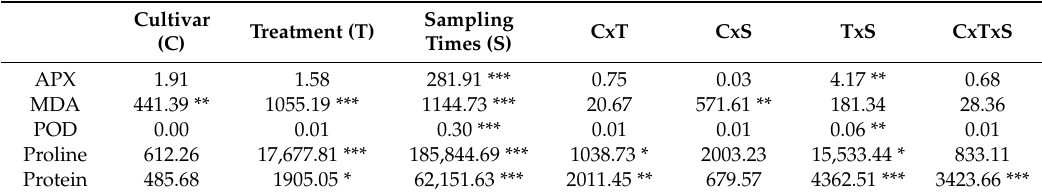
Table 1. The mean squares from the combined analysis of variance for ascorbate peroxidase activity, malondialdehyde content, peroxidase activity, proline, and protein content for two wheat cultivars, with three treatments over two sampling times.